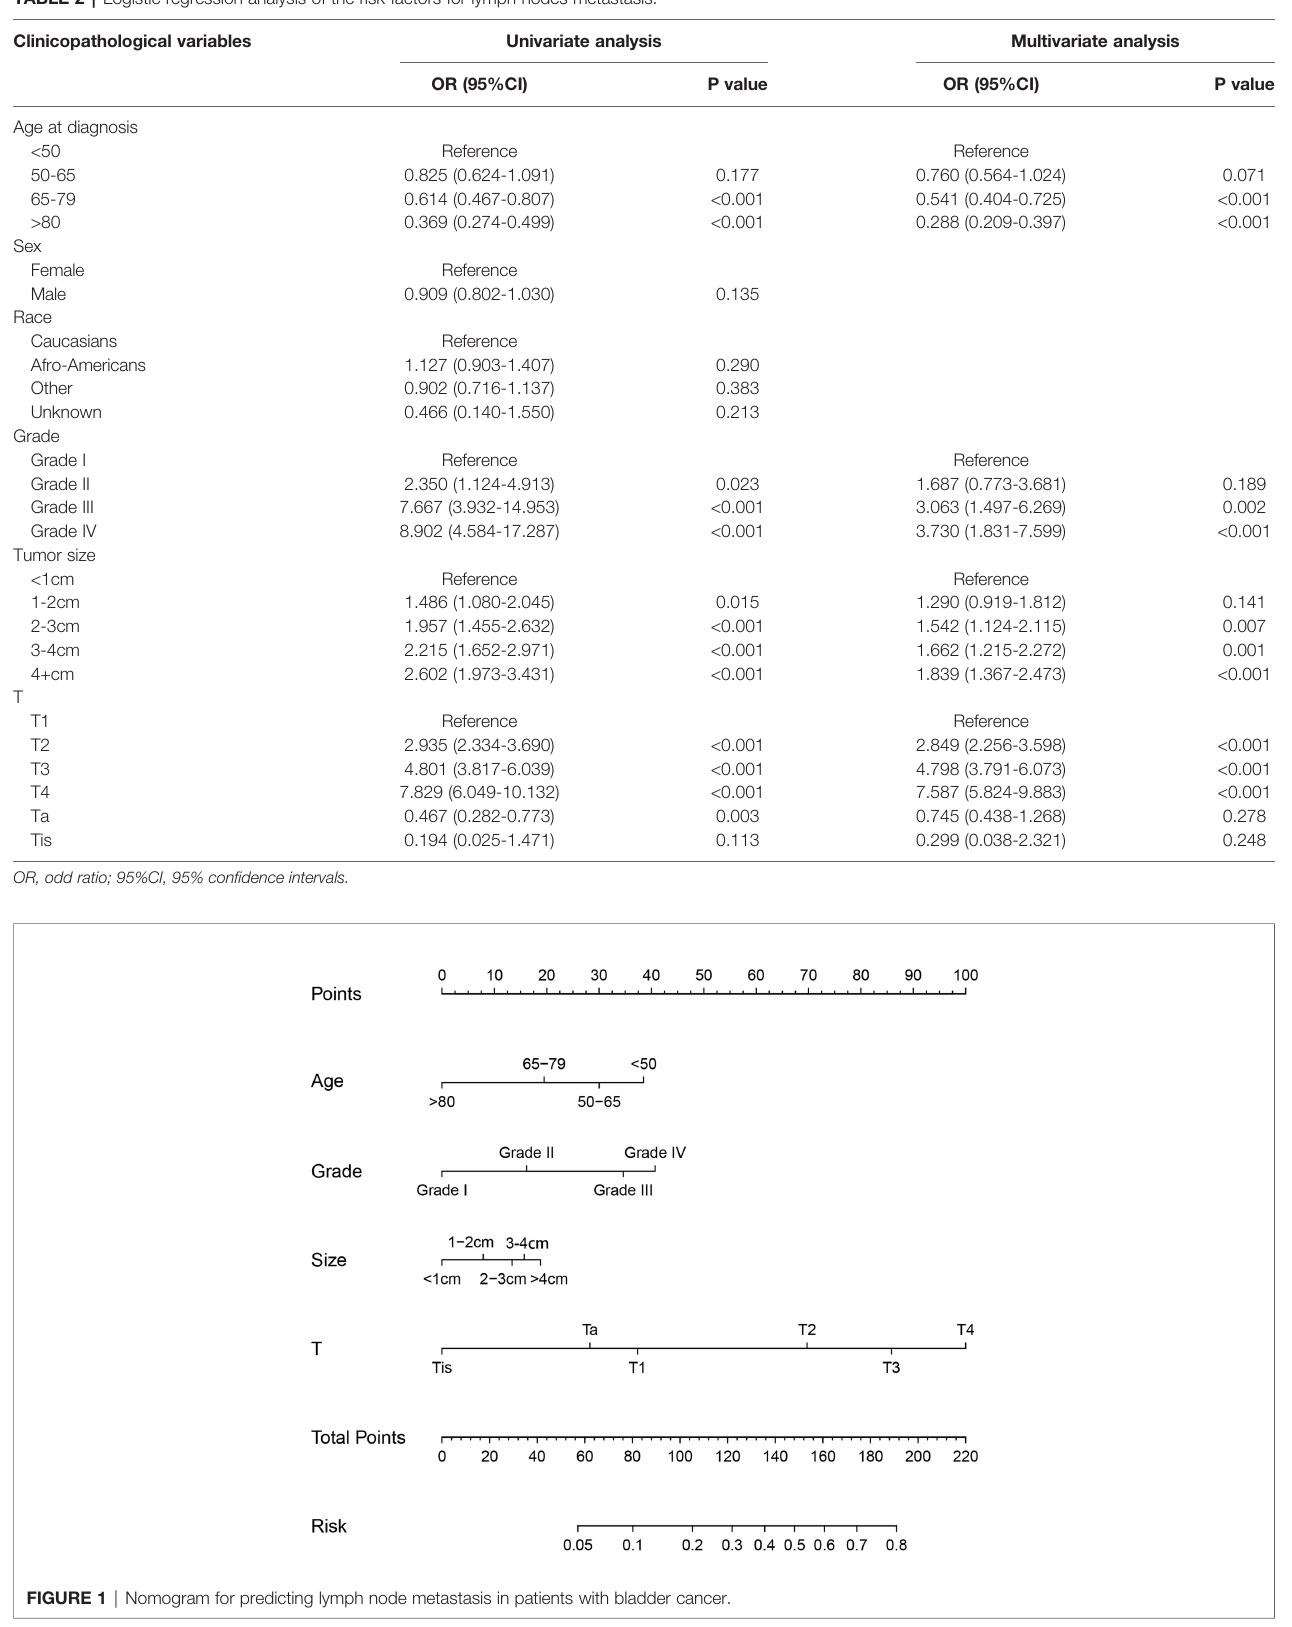
TABLE 2 | Logistic regression analysis of the risk factors for lymph nodes